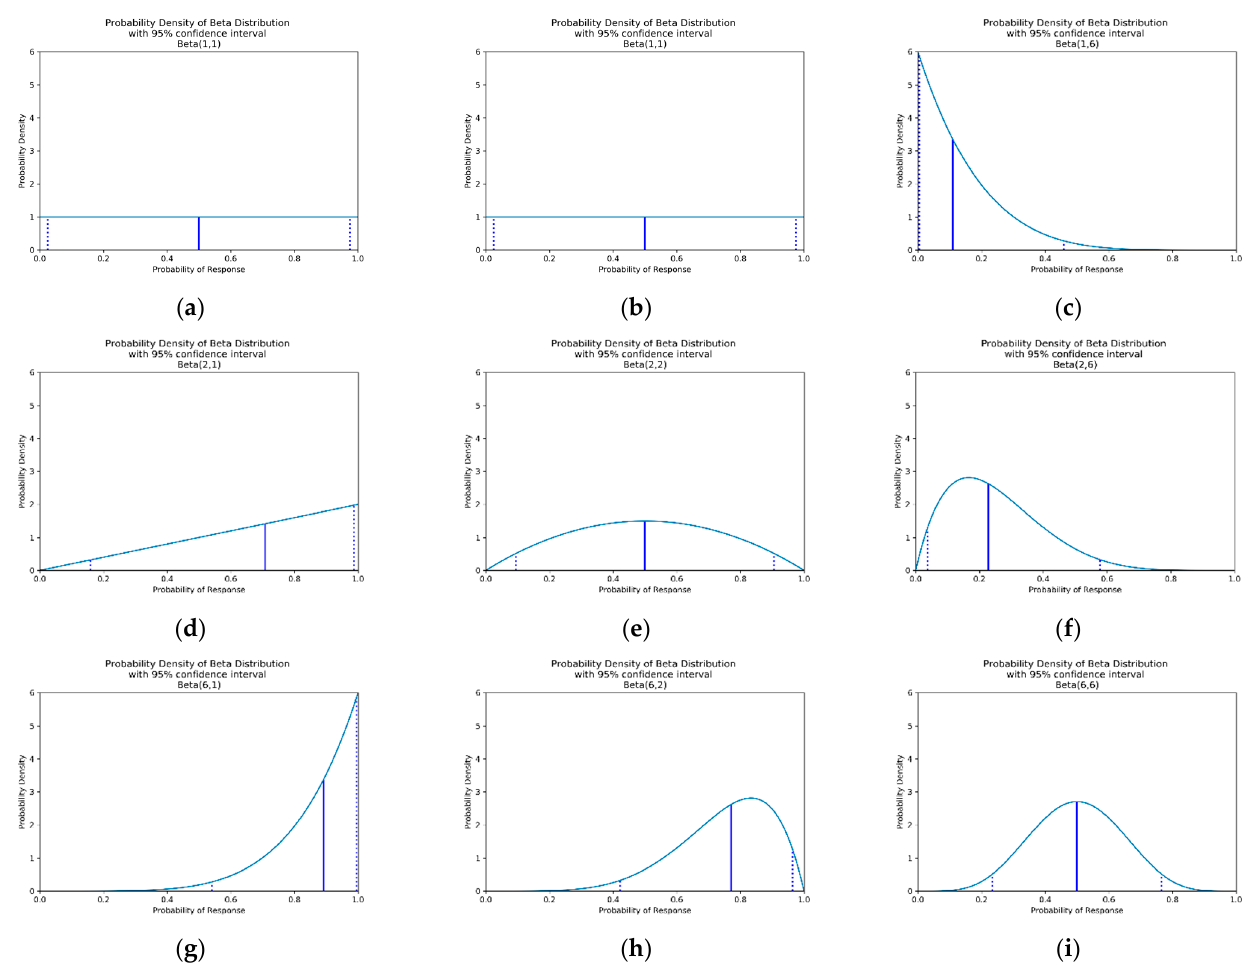
Figure 3. Probability density for beta distributions Beta ( α , β ) with differing values of α and β . The vertical blue line represents the median probability of response (efficacy or toxicity), and the dashed vertical lines represent the 95% confidence interval. If using an uninformative prior ( a ), these represent the probability density after observing: ( a ) 0 responders and 0 non-responders, ( b ) 0 responders and 1 non-responders, ( c ) 0 responders and 5 non-responders, ( d ) 1 responders and 0 non-responders, ( e ) 1 responder and 1 non-responder, ( f ) 1 responder and 5 non-responders, ( g ) 5 re- sponders and 0 non-responders, ( h ) 5 responders and 1 non-responder and ( i ) 5 responders and 5 non-responders.